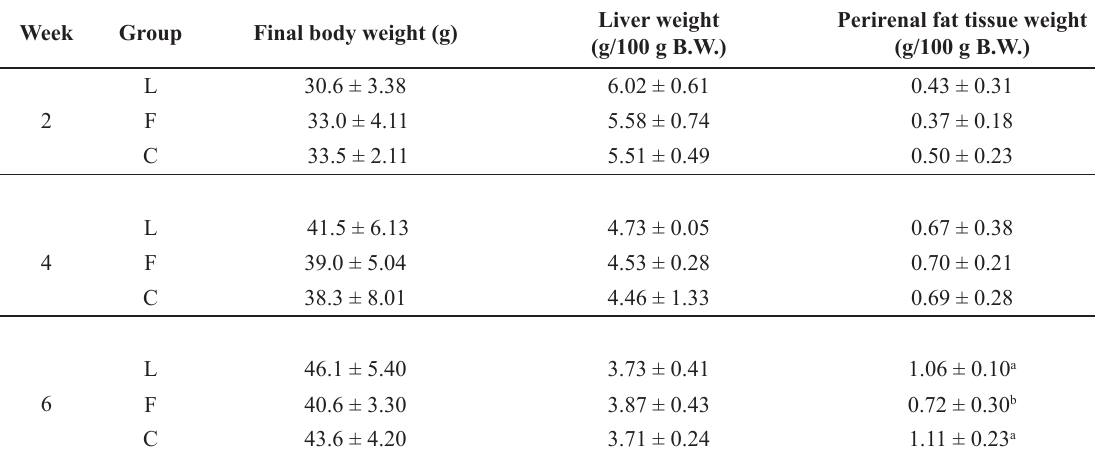
Values represent mean ± SD (n=5). Within a grouping, values not sharing a common superscript letter are significantly different at p <